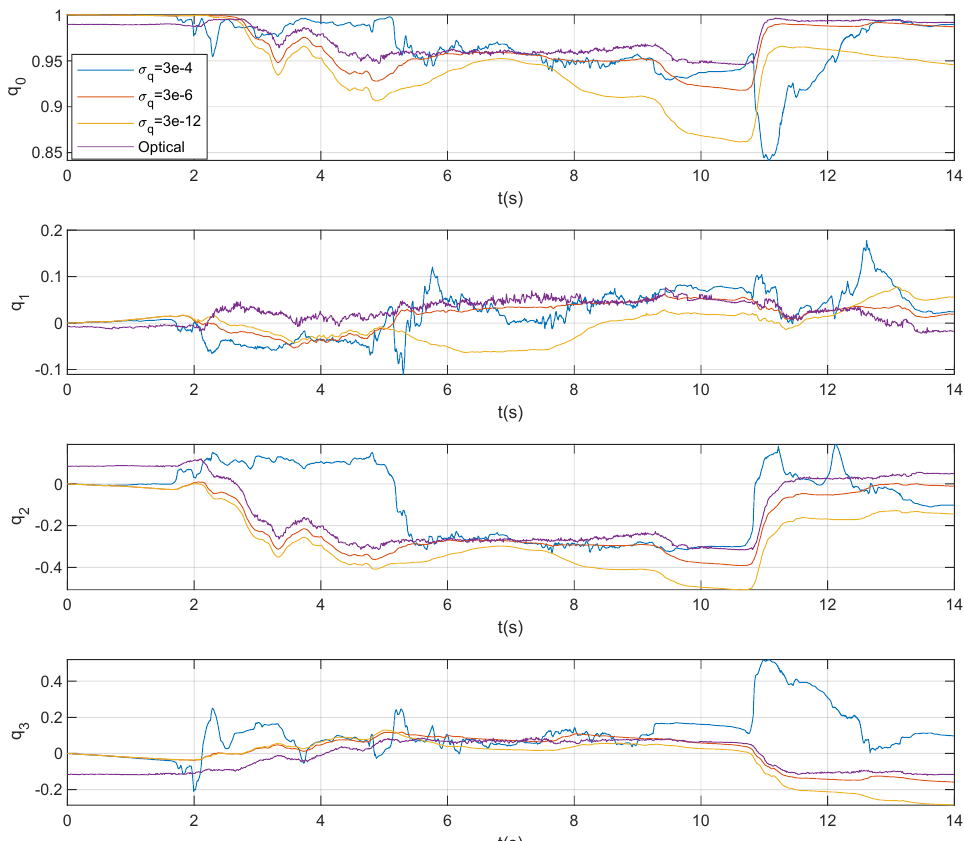
Figure A3. Estimation based on relative orientation between the hand and thumb based on IMU system and optical system. Orientations are expressed based on quaternion; based on these results, we obtained the orientation error in subfigure (c) of Figure 8. σ p has the same meaning as in Figure